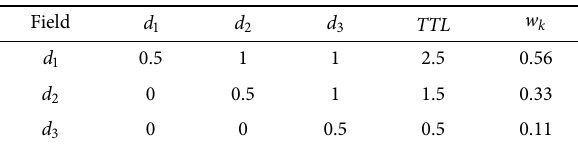
Fig. 2 Collective unit.